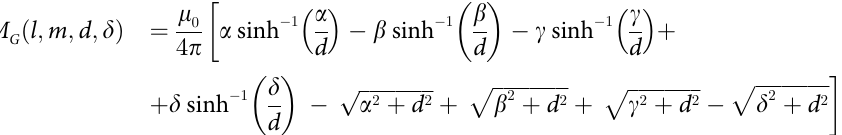
p ffiffiffiffiffiffiffiffiffiffiffiffiffiffi p ffiffiffiffiffiffiffiffiffiffiffiffiffiffiffi p ffiffiffiffiffiffiffiffiffiffiffiffiffiffiffi ffiffiffiffiffiffiffiffiffiffiffiffiffiffiffi b 2 þ d 2 g 2 þ d 2 a 2 þ d 2